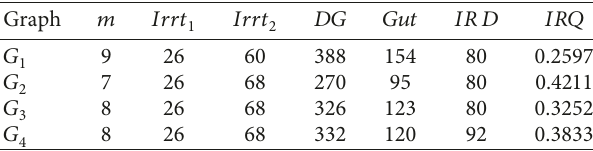
Table 2: Computed topological indices of the four graphs shown in Figure 1.